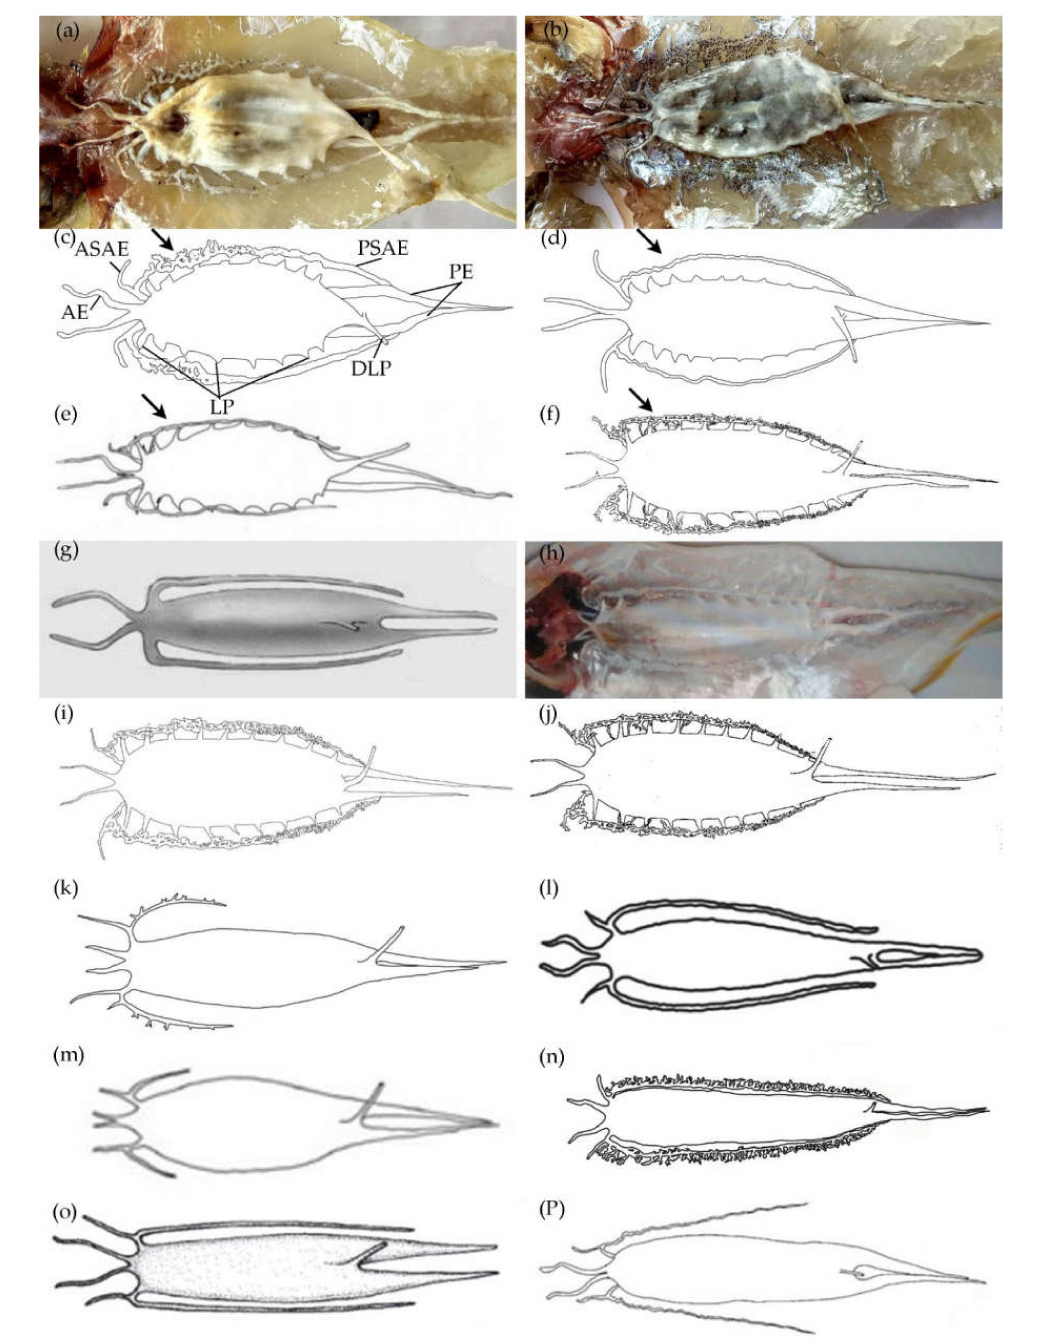
Figure 3. Swimbladder of two Sillago spp. nov. and twelve other Sillago species. ( a , c ) S. muktijoddhai sp. nov.; ( b , d ) S. mengjialensis sp. nov.; ( e ) S. indica [45]; ( f ) S. cf. sihama 3 (cid:13) (cryptic species in the Sillago sihama complex), China [11]; ( g ) S. sihama , Red Sea [8]; ( h ) S. malabarica [12]; ( i ) S. shaoi [9]; ( j ) S. nigrofasciata [11]; ( k ) S. sinica [7]; ( l ) S. suezensis [8]; ( m ) S. panhwari [22]; ( n ) S. parvisquamis [11]; ( o ) S. intermedius [5]; ( p ) S. caudicula [6]. AE: anterior extension, ASAE: anterior sub-extension of anterolateral extension, PSAE: posterior sub-extension of anterolateral extension, LP: lateral processes, DLP: duct-like process, PE: posterior extension. Black arrows indicate differences between new and other Sillago